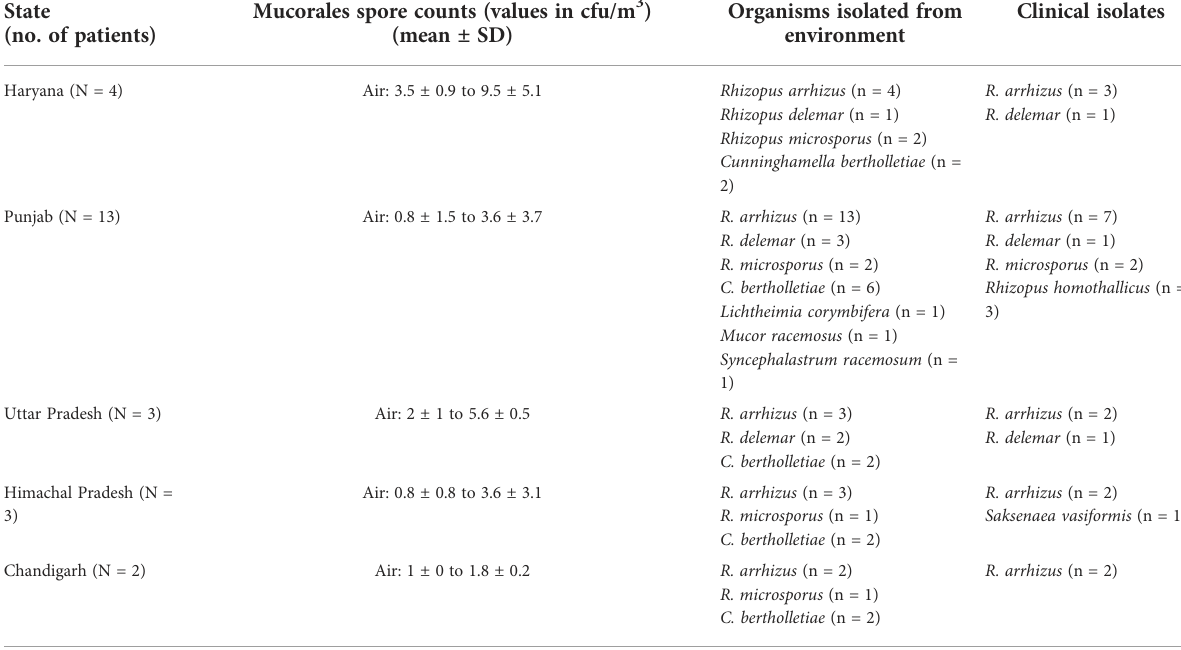
TABLE 1 The state-wise details of different Mucorales species isolated in environmental samples from residential areas of patients with COVID- 19-associated mucormycosis and its spore counts. State (no. of